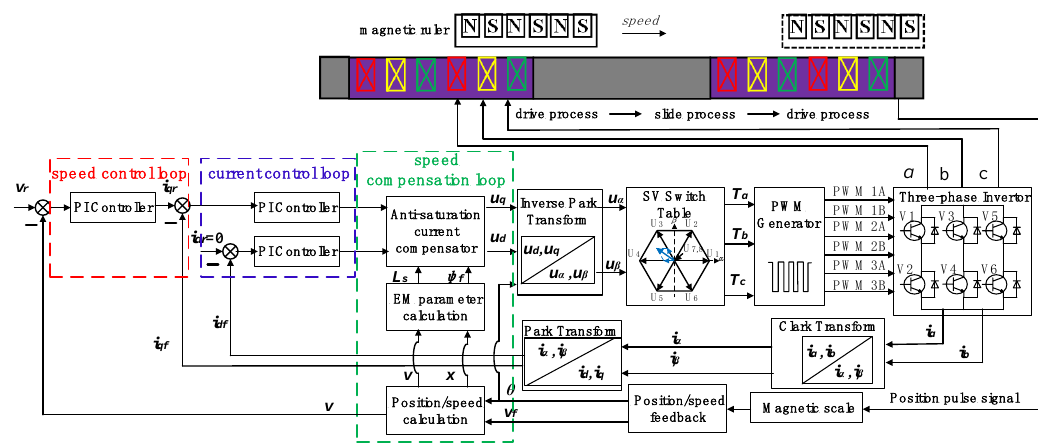
Figure 5. Control model of segmented PMLSM during switch process.